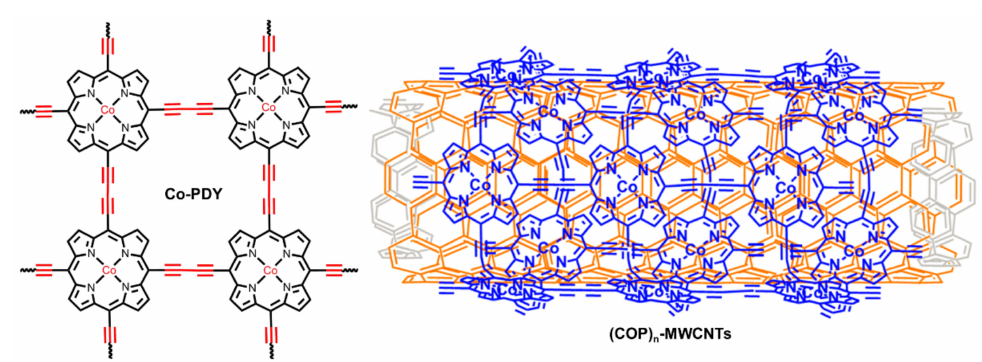
Figure 13. Porphyrin-based graphdiyne type covalent organic frameworks for heterogeneously electrochemical OER. Reproduced from ref. [86]. Reprinted with permission from ref. [88]. Copyright 2015 American Chemical